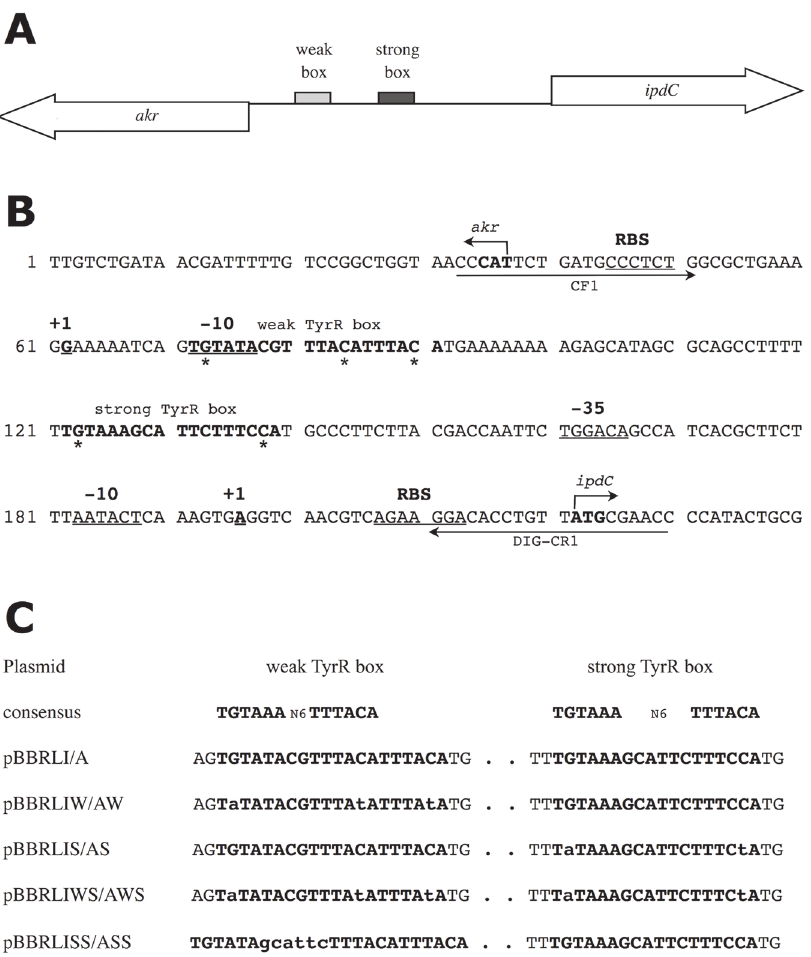
Fig 1. The akr-ipdC regulatory region of E . cloacae UW5. (A) Relative location of the two TyrR binding sites located between the akr and ipdC genes. (B) Nucleotide sequence of the akr-ipdC intergenic region. TyrR boxes are in bold and nucleotides proposed to be essential are indicated with asterisks. The predicted − 10, − 35 elements and ribosome binding sites for both genes are underlined. The identified ipdC transcription start site, and predicted akr transcription start site are in bold underline. Arrows above the sequence indicate the akr and ipdC start codons. Arrows below the sequence indicate primer binding sites for CF1 and DIG-CR2. (C) Reporter gene expression plasmids driven by the ipdC (I) or akr (A) promoters, with the corresponding mutation or insertions indicated in lowercase compared to the TyrR box consensus